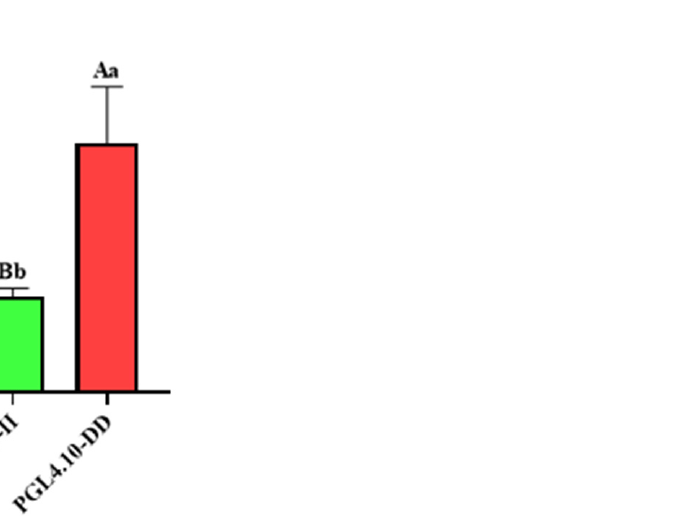
Figure 4. The expression level of GHR gene mRNA in different tissues of yak. 4. Discussion SV is a major determinant of the phenotypic diversity of animals. Studies on chickens [21], sheep [22], and cattle [10] have reported that SVs play a significant role in their genetic diversity. In poultry, the SVs of prolactin receptor ( PRLR ) [23] and Lpin1 [24] were significantly associated with chicken growth, carcass characteristics, and other economic traits. In cattle, the SVs of SIRT4 and NPM1 were significantly associated with bovine growth traits and meat quality [25,26]. These studies show that SV is an important class of molecular genetic markers, which is of great value in revealing the genetic mechanism of the economic traits of livestock and poultry.